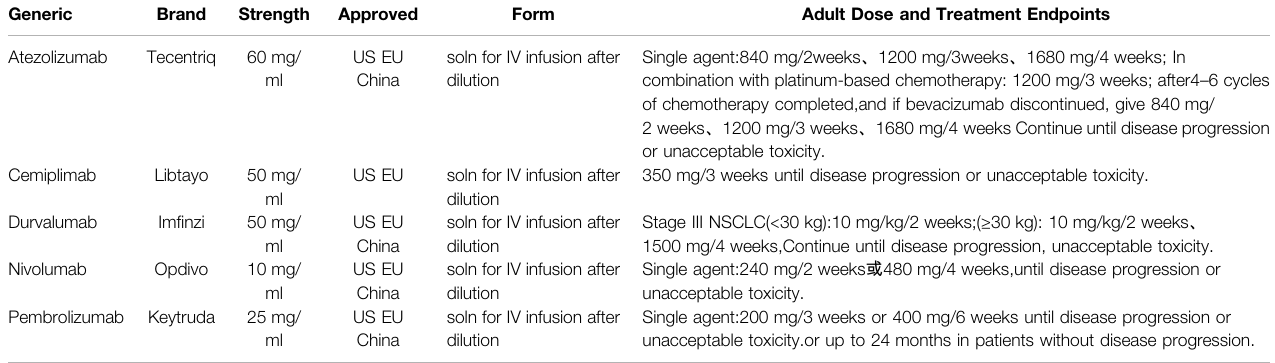
TABLE 2 | FDA/EMA/NMPA-approved NSCLC treatments of PD-1/PD-L1 blocking antibodies.